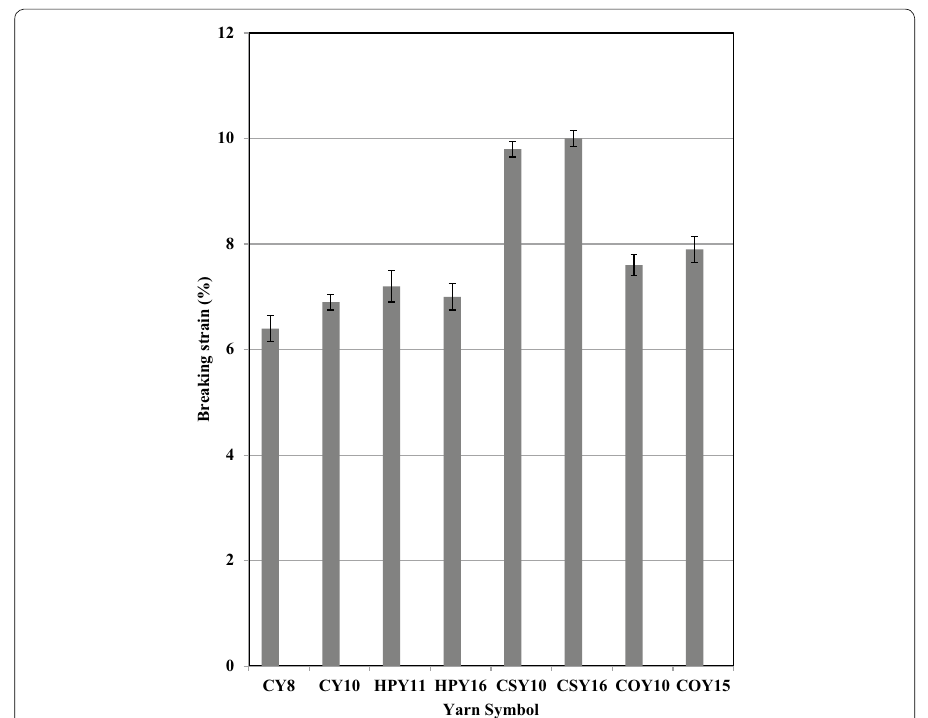
Fig. 2 Breaking strain of warp and weft yarn used for Hanji denim